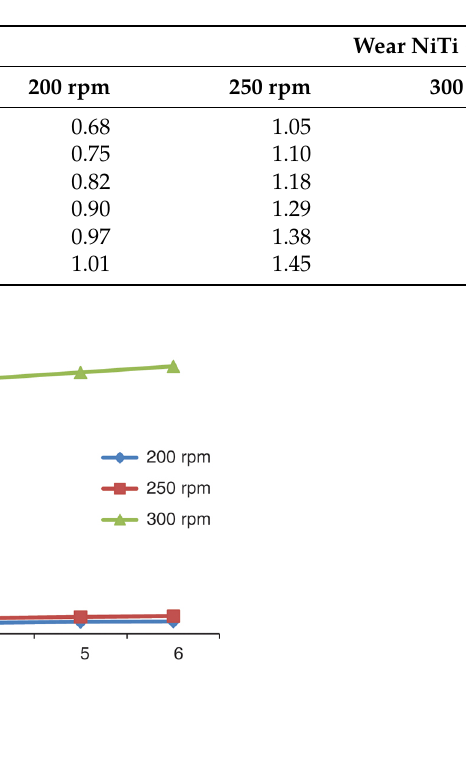
Table 4: Wear rate in NiTi alloy.